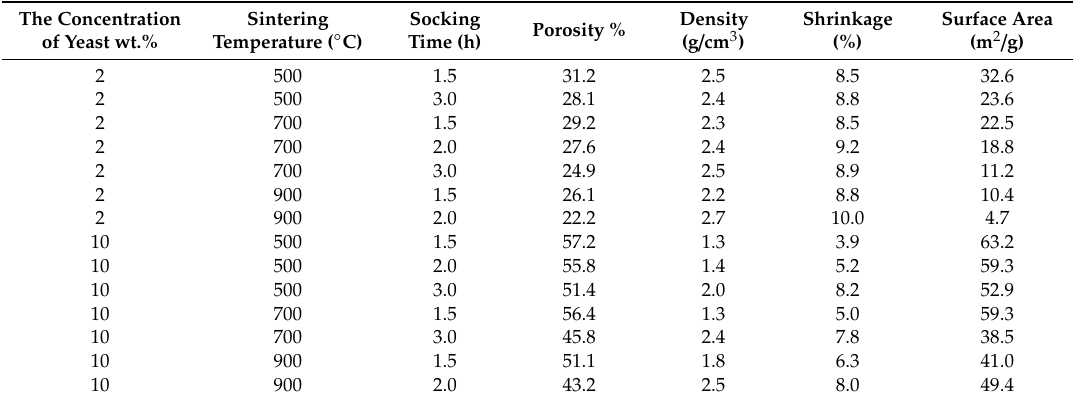
Table 2. The processing parameters of the training